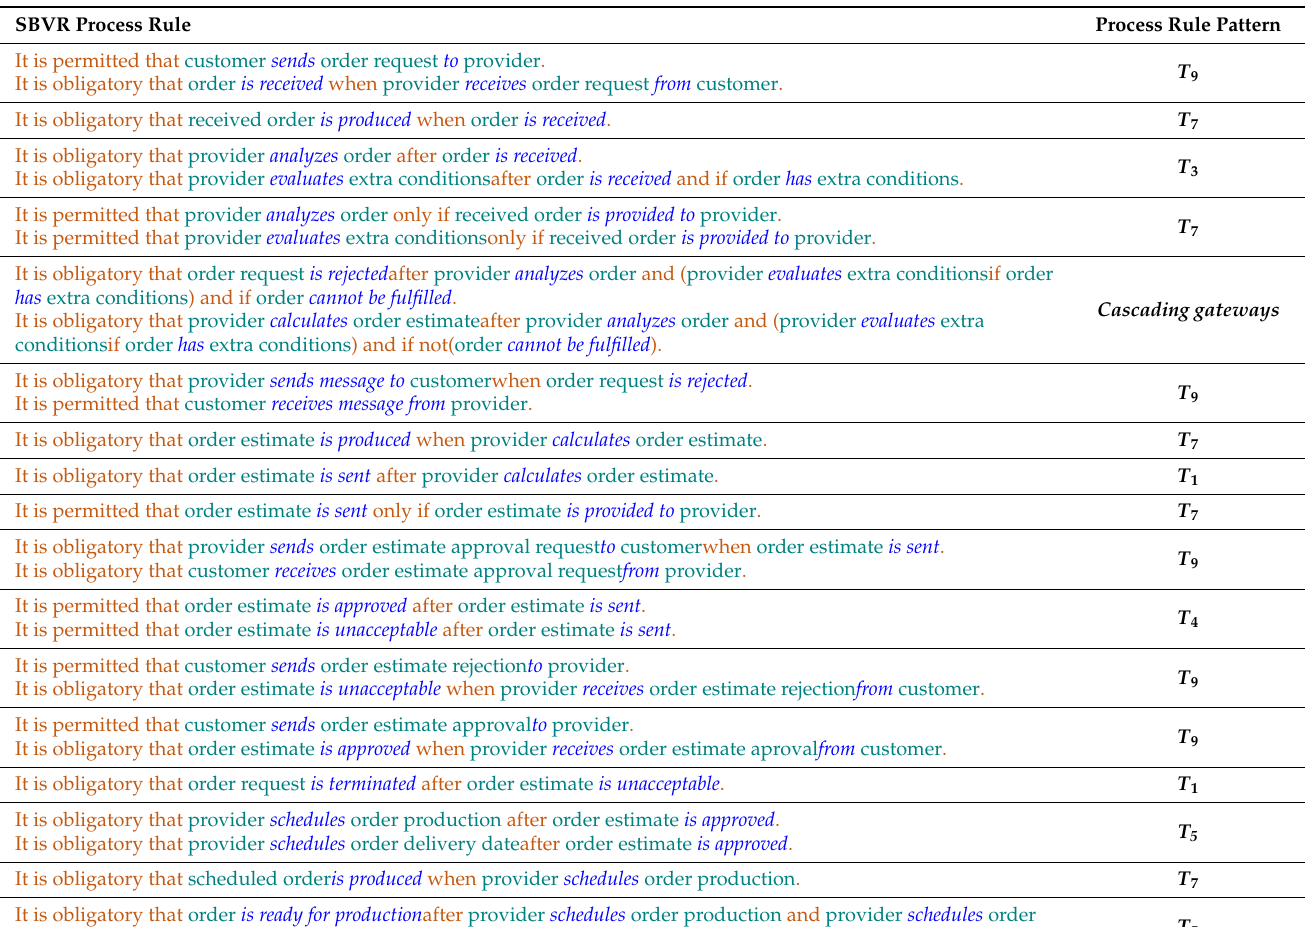
Table 3. A set of SBVR process rules extracted from the business process “Order Registration”.